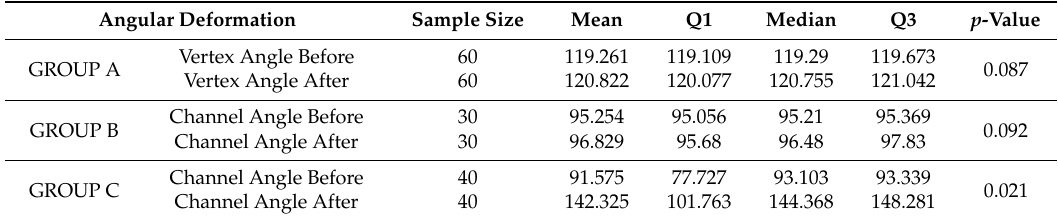
Table 2. Angular Deformations of Internal Connections. Statistical comparison for the three groups before and after implant insertion. p values are assigned for each comparison within groups (before and after implant insertion). Significance was set as p < 0.05.